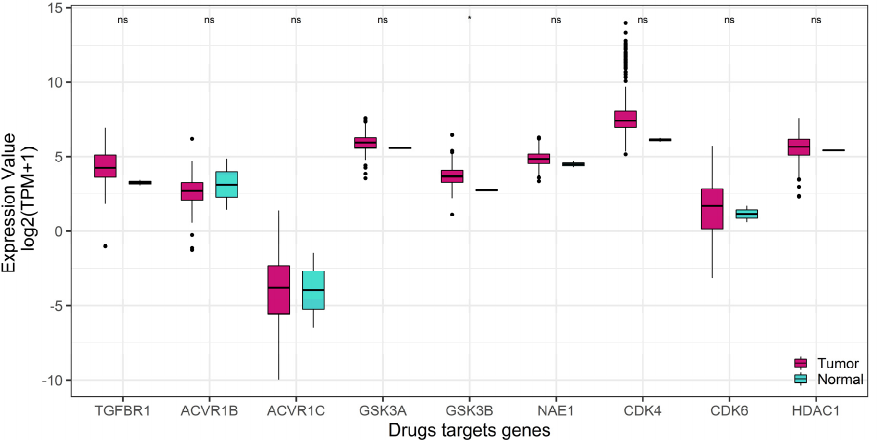
Figure 3. Expression of the nine target genes in tumor and normal samples (TCGA Sarcoma dataset). Expression values of genes are log 2 –transformed. Statistical significance was assessed by ANOVA. Number of patients: tumor = 262, normal =